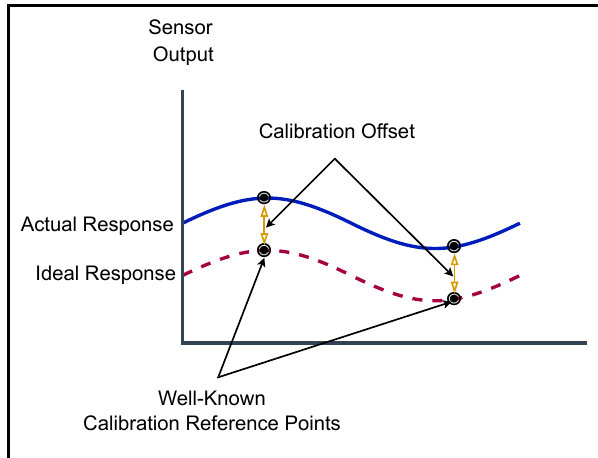
Figure 9. Sensor Calibration.